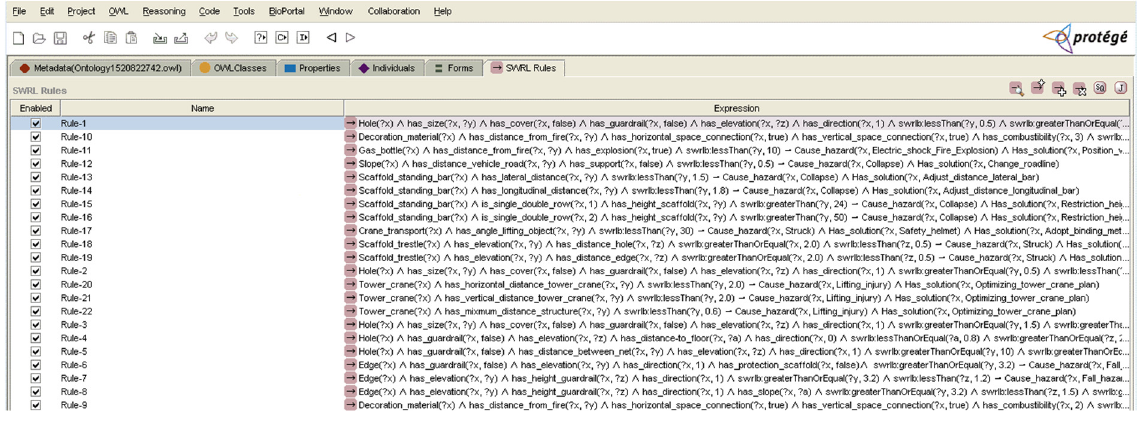
Figure 8. SWRL safety rule library for major safety risks.